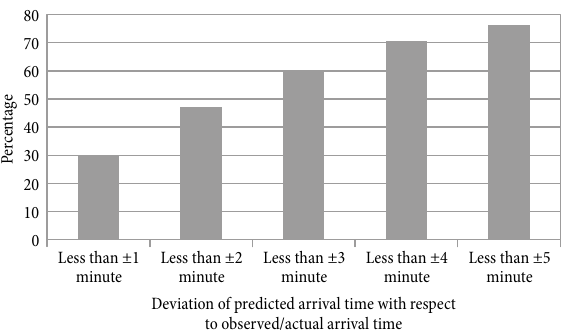
for off-peak and peak trips